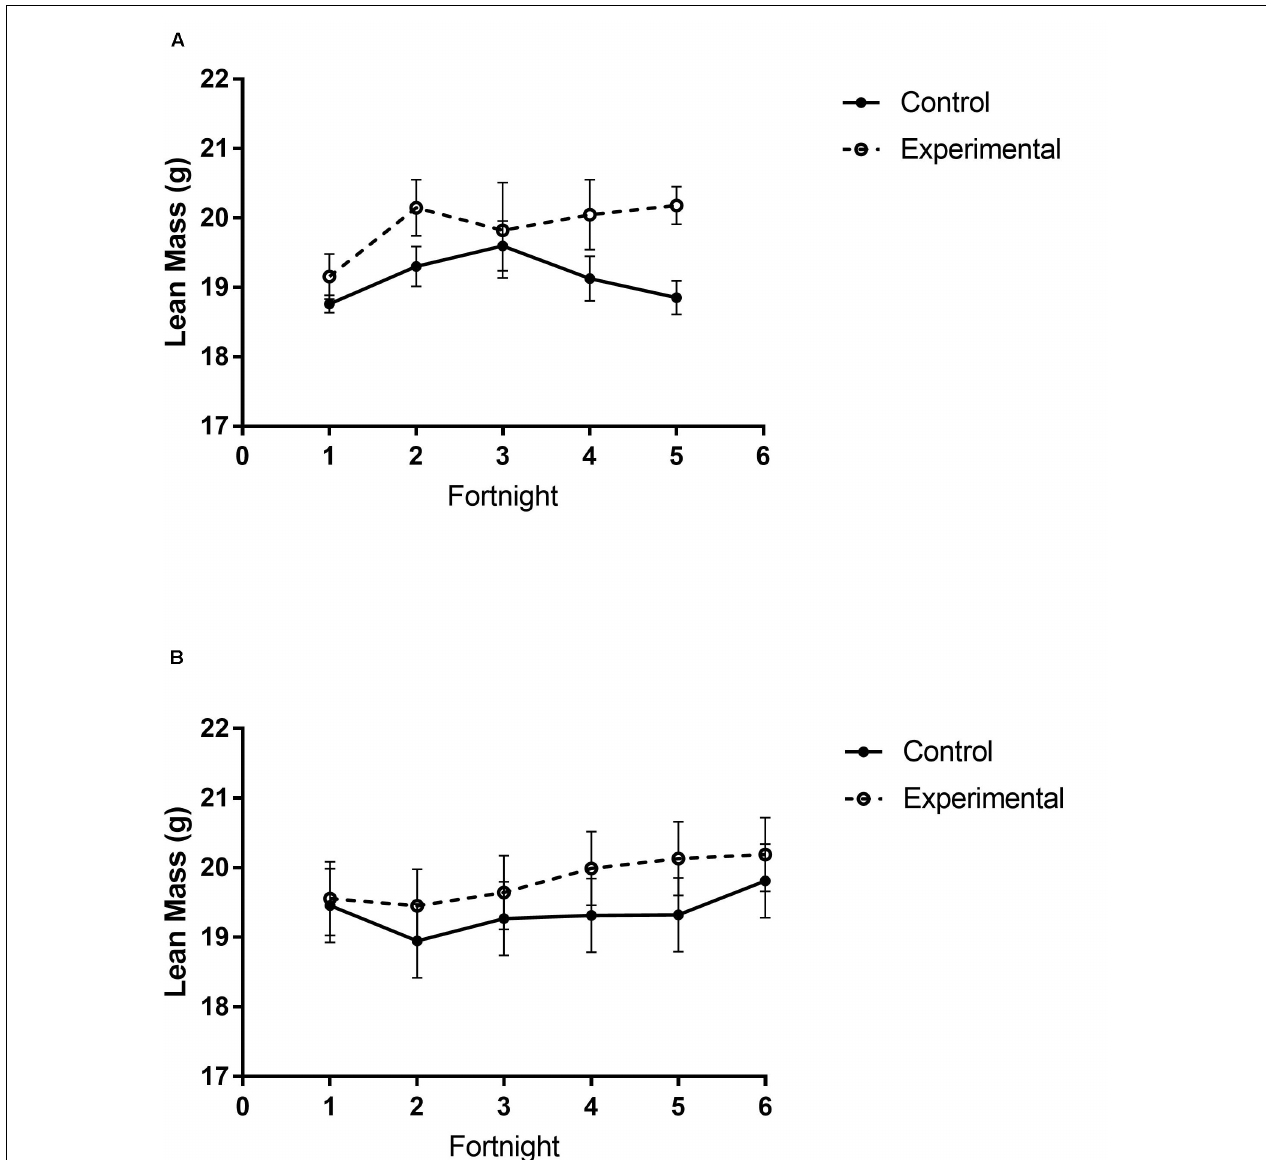
FIGURE 4 | Lean mass content of white-throated sparrows exposed to (A) low-frequency inclement weather conditions (study 1) or (B) high-frequency inclement weather conditions (study 2). (A) Experimental birds had higher lean mass content. (B) There were no differences in lean mass between groups. Points indicate mean total mass values and error bars indicate